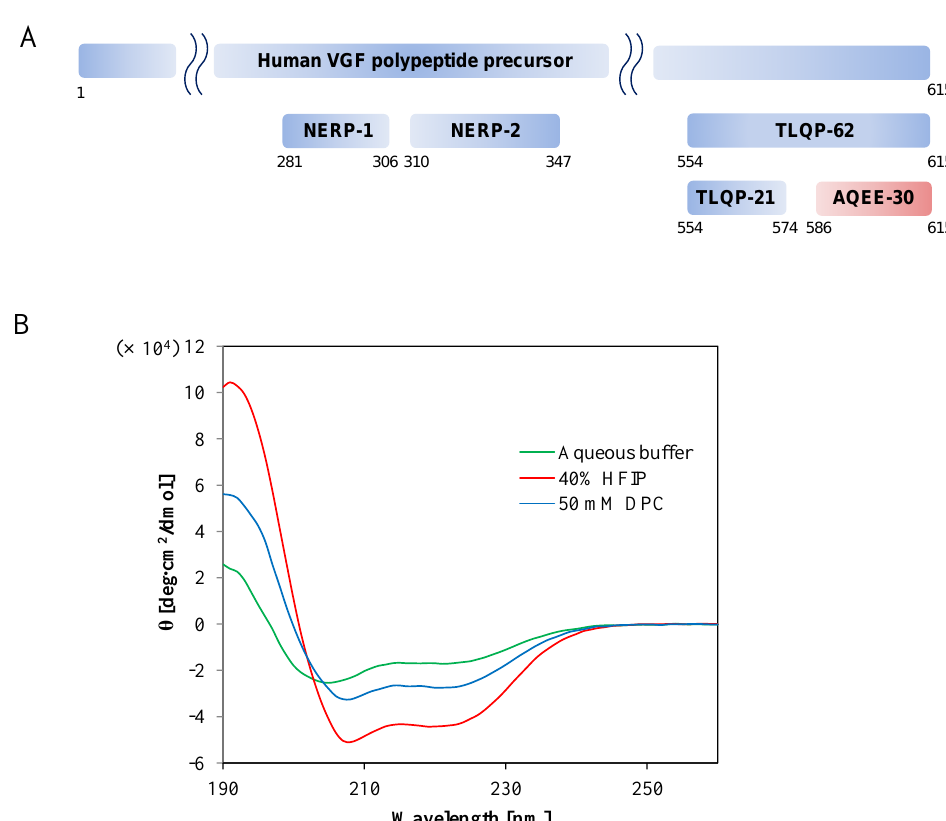
Figure 1. ( A ) Schematic representation of the human VGF polypeptide precursor and peptides. AQEE-30 is marked by reddish color. ( B ) Far-UV CD spectra of AQEE-30 at pH 7.4 in 40 % HFIP (red) and 50 mM DPC (blue) solutions. Far-UV CD spectra of AQEE-30 in aqueous buffer (green) at pH 7.4 were also measured as a control. In each measurement three scans were performed and averaged and backgrounds were